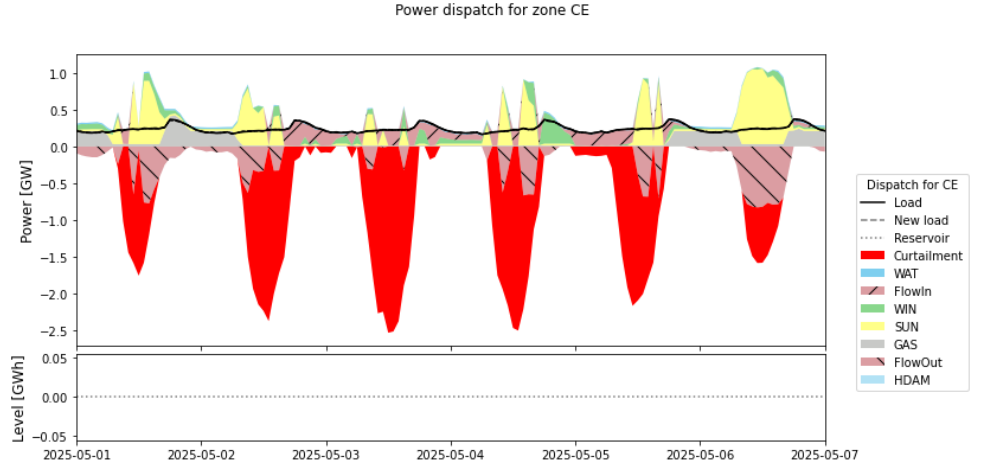
Figure 30. Very-High-Penetration Scenario 10(NH)—Central zone (1–7 May 2025).